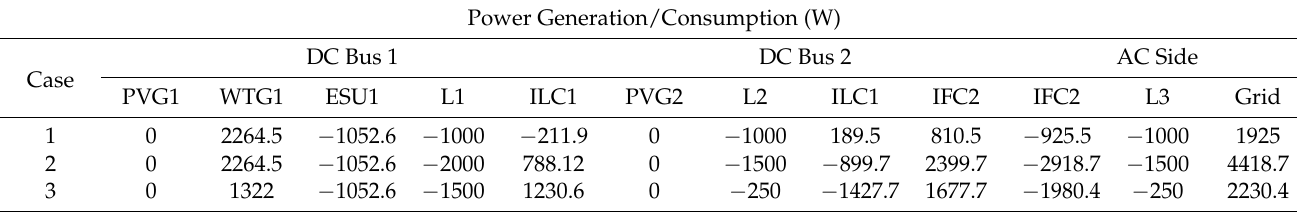
Table 10. Results for scenario 1 evaluated for the three selected cases.